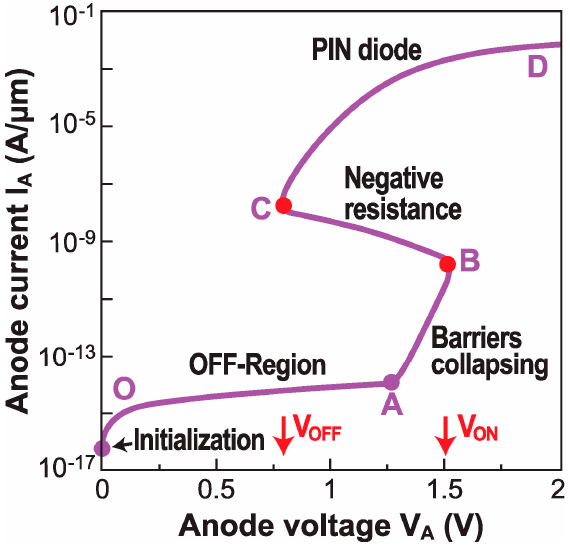
Figure 9. S-shaped output characteristic I A -V A computed with Taur’s physical model [28] and Martinie’s compact model [29]. The capitals separate the five regimes in steady-state operation. Point O: ‘Initialization’ : The front gate and back gate are biased to produce the NPNP electrostatic structure, by transforming the PIN diode into a virtual thyristor (Figure 10a). The potential profiles are governed by the two MOS capacitors, respectively formed by (i) the gate and the overlapped body, and (ii) the back gate, the BOX, and the underlapped body (see Figure 11a).